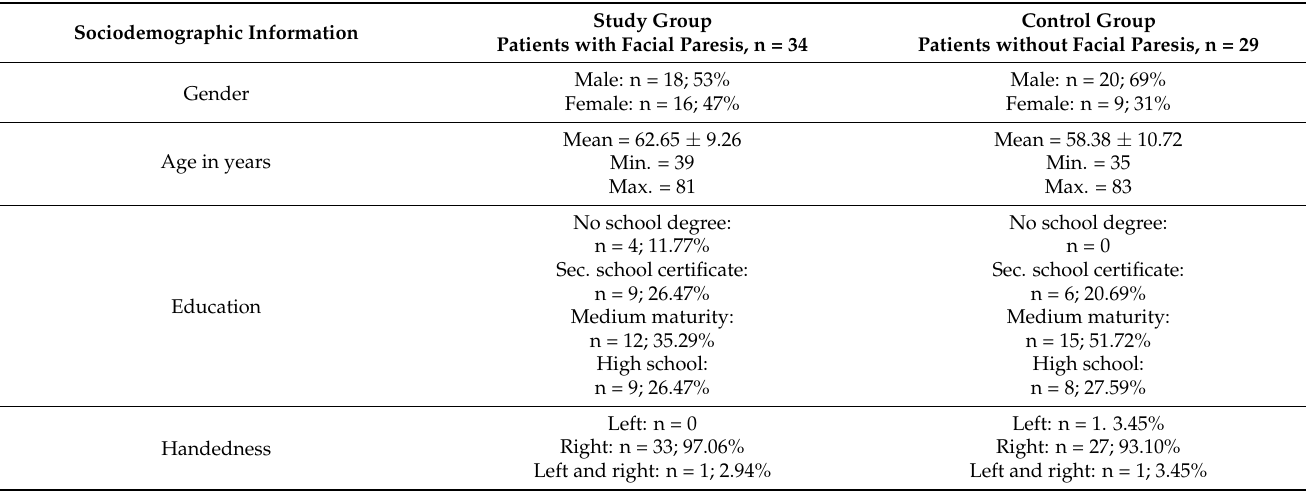
Table A1. Sociodemographic information on gender, age, education and handedness in the study group and control